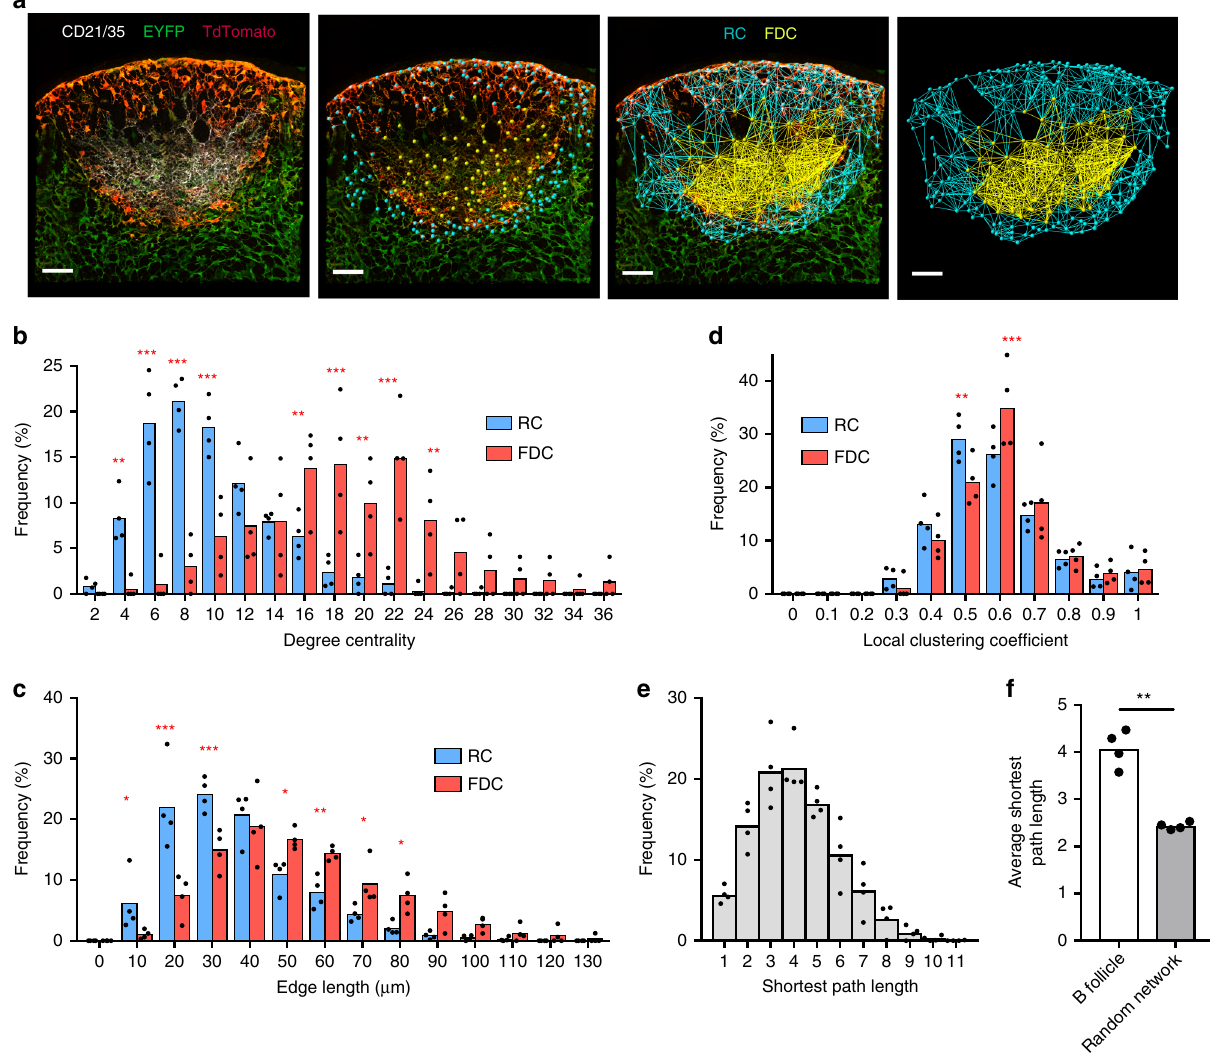
Fig. 1 The topological network properties of CXCL13 + follicular stromal cells. a Mapping confocal images of lymph node follicles taken from Cxcl13-cre/ EYFP reporter mice using the Imaris image analysis software. The FDC subnetwork is highlighted in yellow and the RC subnetwork in cyan. Distributions of degree centrality, edge length and local clustering coef fi cient are indicated for the FDC and RC subnetworks ( b − d ). e Distribution of shortest path lengths is indicated for the global follicular network and are compared to that of an equivalent random network with the same number of nodes and edges ( f ). Data represent mean ± SD for n = 4 mice. Statistical signi fi cance was determined using a two-way ANOVA with Sidak ’ s multiple comparison test. * p < 0.05, ** p < 0.01, *** p < 0.001. Scale bar = 50 μ m. Source data are provided as a Source Data fi